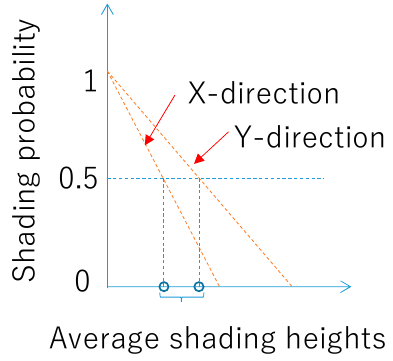
Figure 2. The distribution curve of the shading probability used to the model.